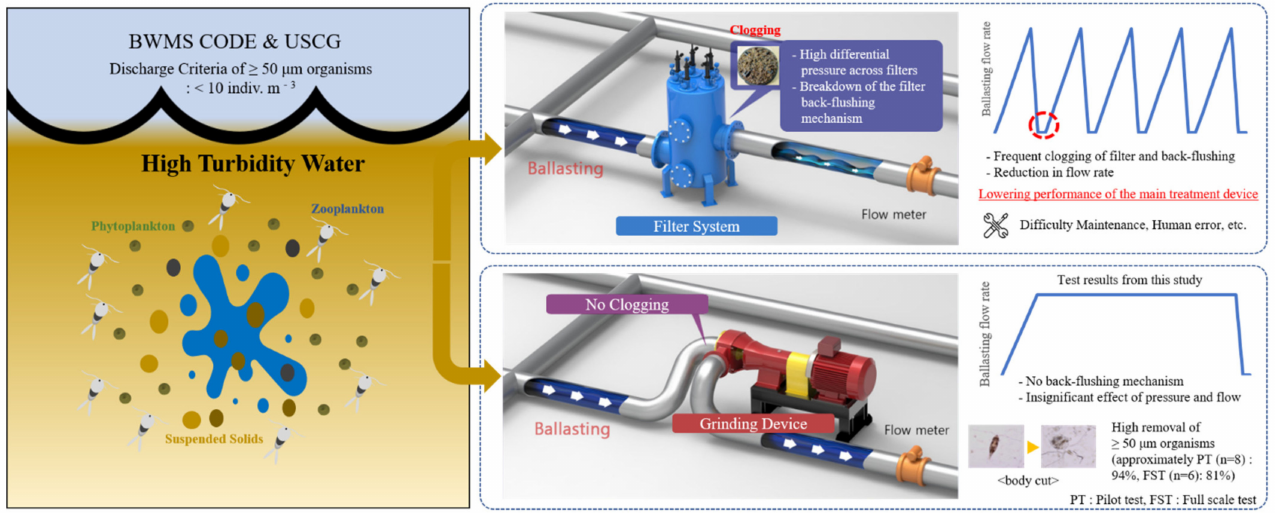
Figure 7. Summary of test